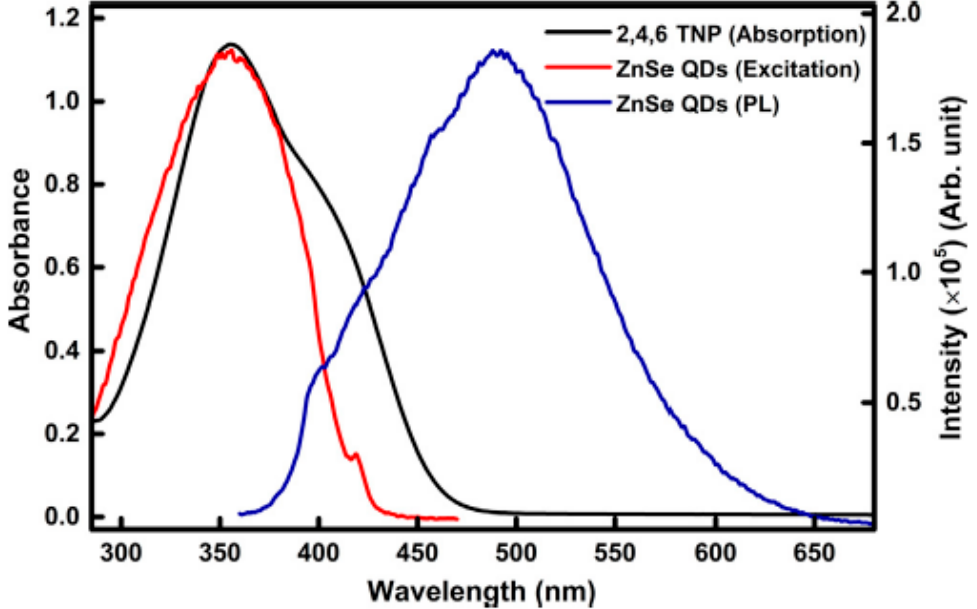
Figure 1. Spectral overlapping of the absorption spectrum of 2,4,6 TNP with PL and the PL excitation spectra of ZnSe QDs [25].